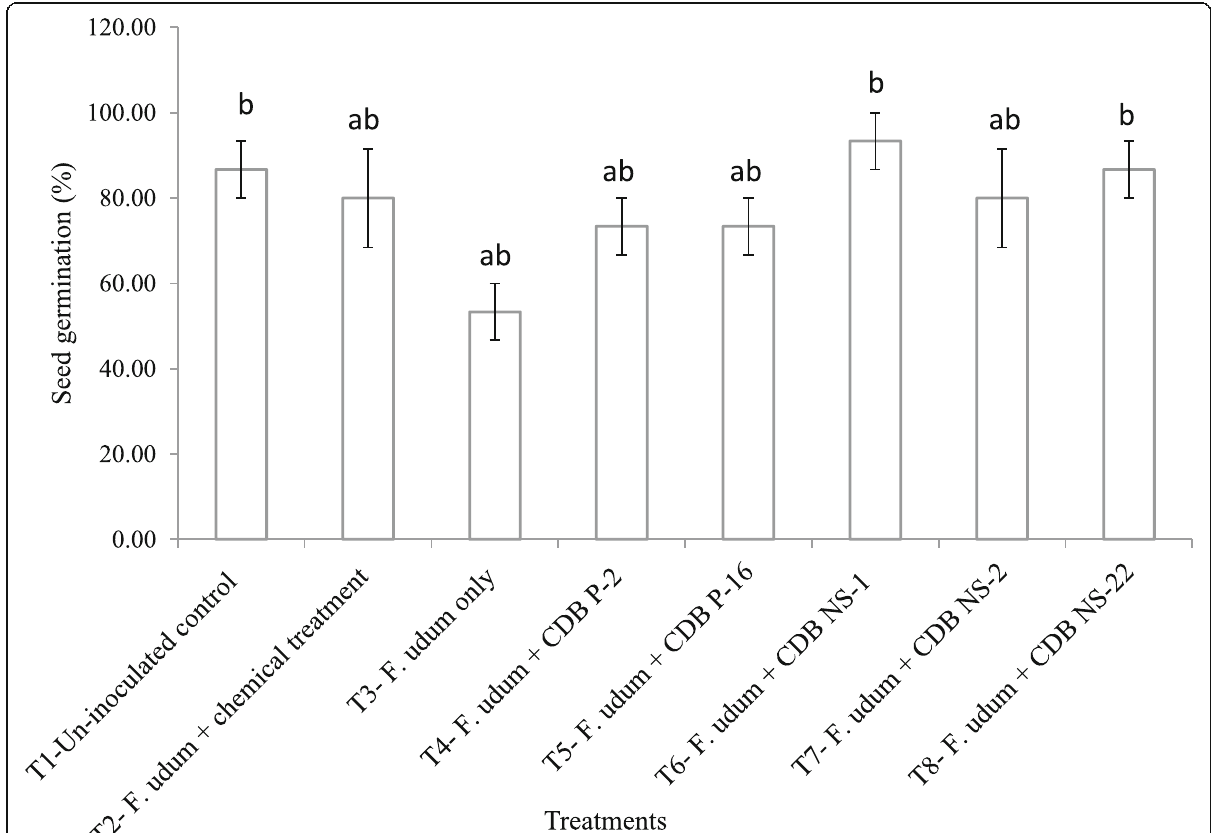
Fig. 3 Effect of seed bacterization with chitinolytic bacteria on germination (%) of pigeon pea under F . udum pre-challenged conditions. Values are mean of three replications ± standard errors